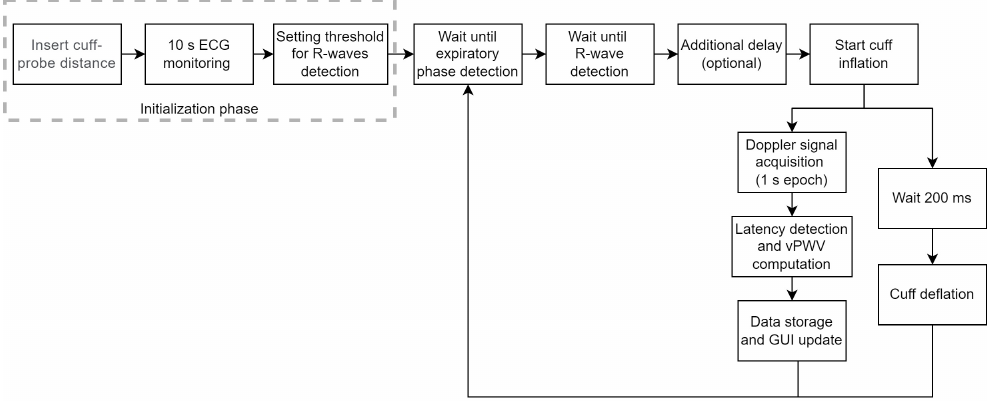
Figure 1. Flowchart of measurement. Compressive stimulus synchronized with respiratory and cardiac cycle. PW transition under Doppler probe allows for calculating vPWV.